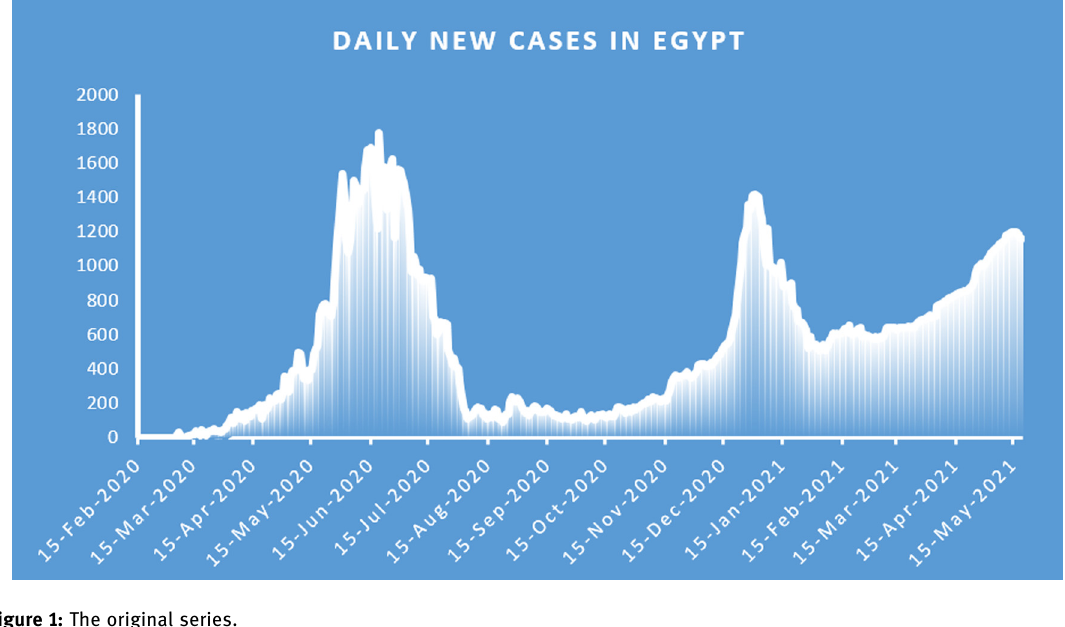
Figure 1: The original series.